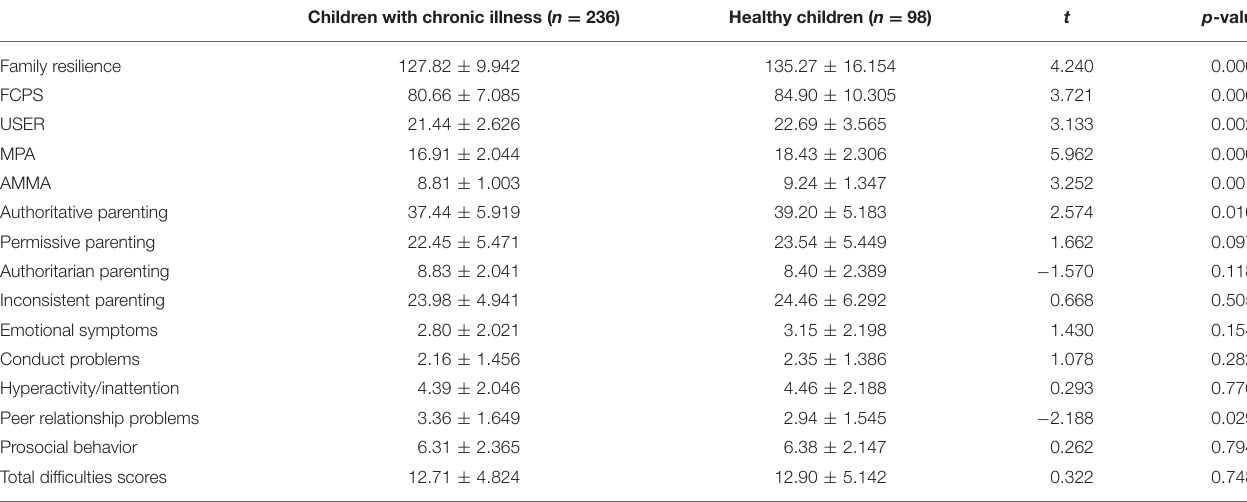
TABLE 2 | Differences in family resilience, parenting styles and child psychosocial adjustment by childhood chronic illness history ( n =